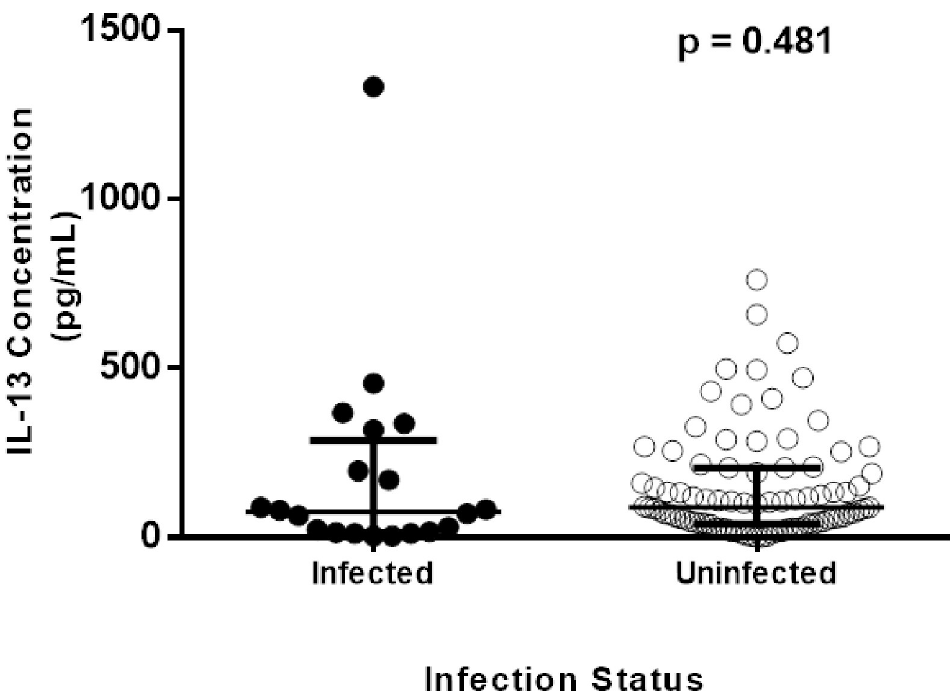
Fig 2. Comparison of IL-13 cytokine levels in schistosomiasis infected and uninfected.